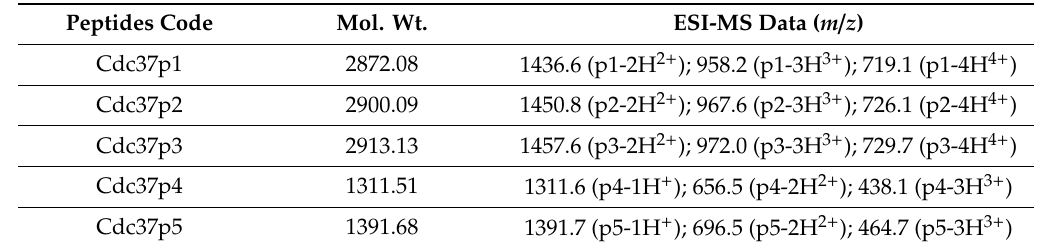
Table 3. Characterization data of peptides synthetized, obtained by ESI-MS in positive-ion